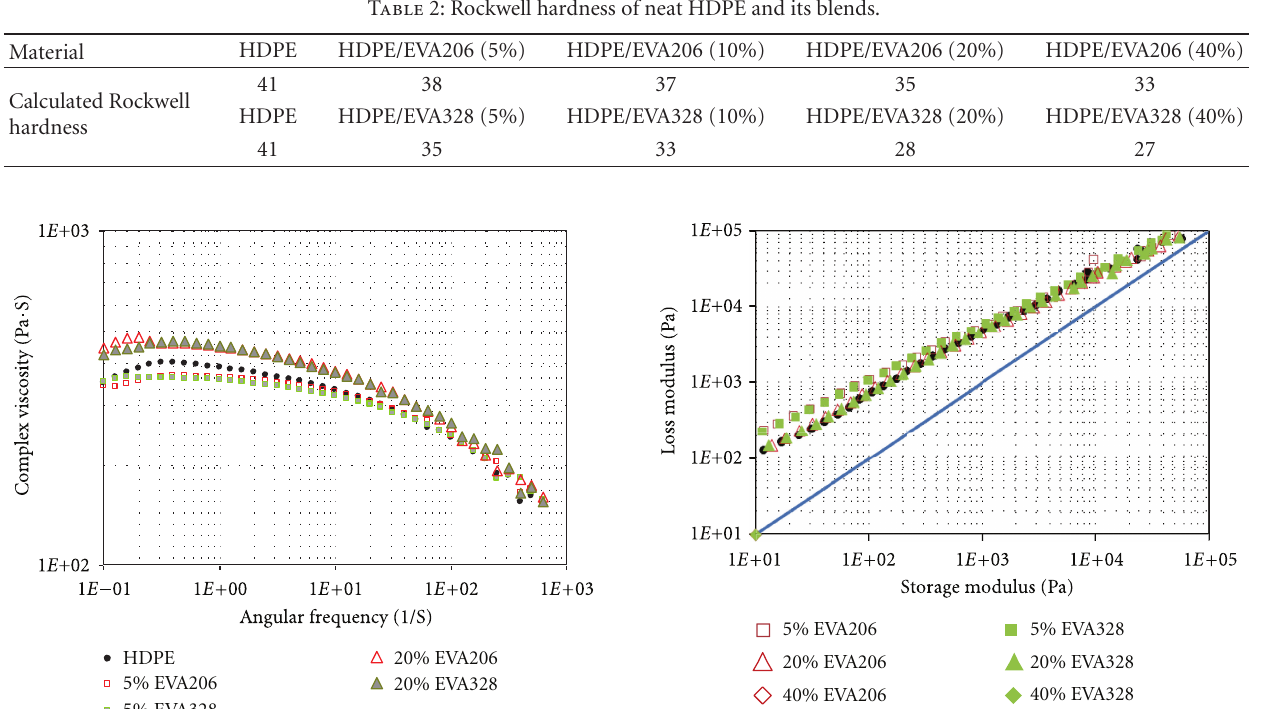
Figure 6: Complex viscosity at di ff erent ratios of HDPE/EVA206 and HDPE/EVA328.